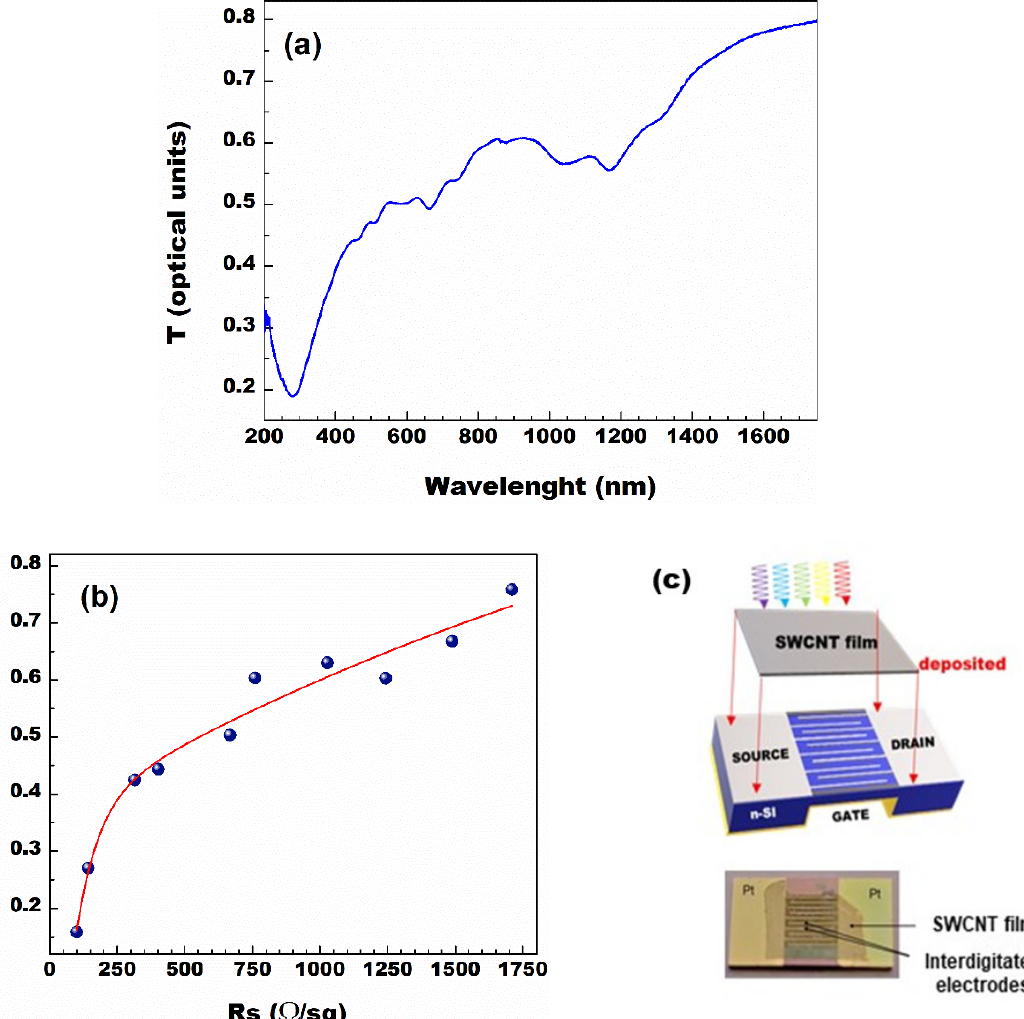
Figure 1. ( a ) Optical transmittance ( T ) of single wall carbon nanotube (SWCNT) films as a function of the incident photon wavelength, λ . ( b ) Optical transmittance ( T ) of SWCNT films at fixed incident wavelength λ = 550 nm vs their sheet resistance ( R S ). The red curve is a fit obtained following the Equation (1). The free parameter in the fit is the ratio σ ac / σ dc which is found to be equal to 1.2 ± 0.1. ( c ) Top panel: Sketch of the device. In order to better display the multifinger top electrode, the SWCNT film is artificially reported lifted with respect to the active area. Red arrows indicate where the SWCNT film was deposited through the dry-transfer printing process. Bottom panel: a picture of the device. Note the high transparency of the SWCNT film that allows to still see the interdigitated contacts.